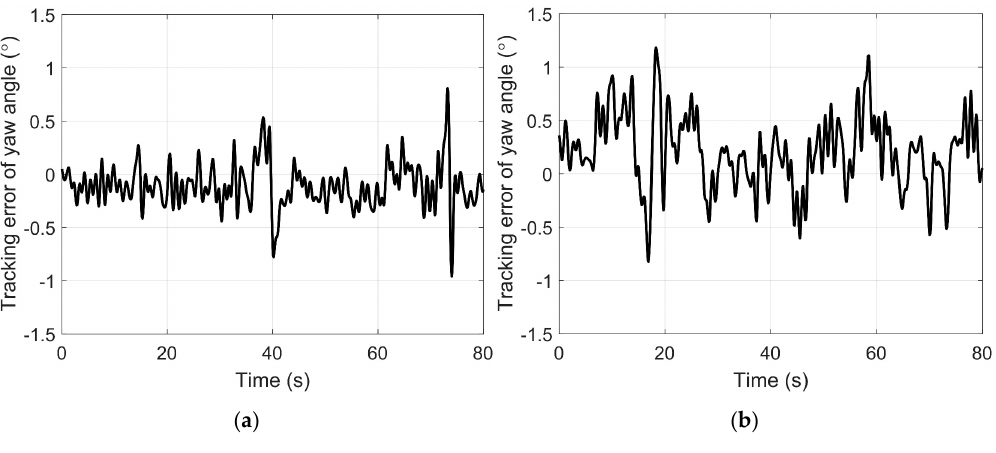
Figure 31. Tracking errors of yaw angle using different control schemes: ( a ) FTADRC; ( b ) conventional ADRC.